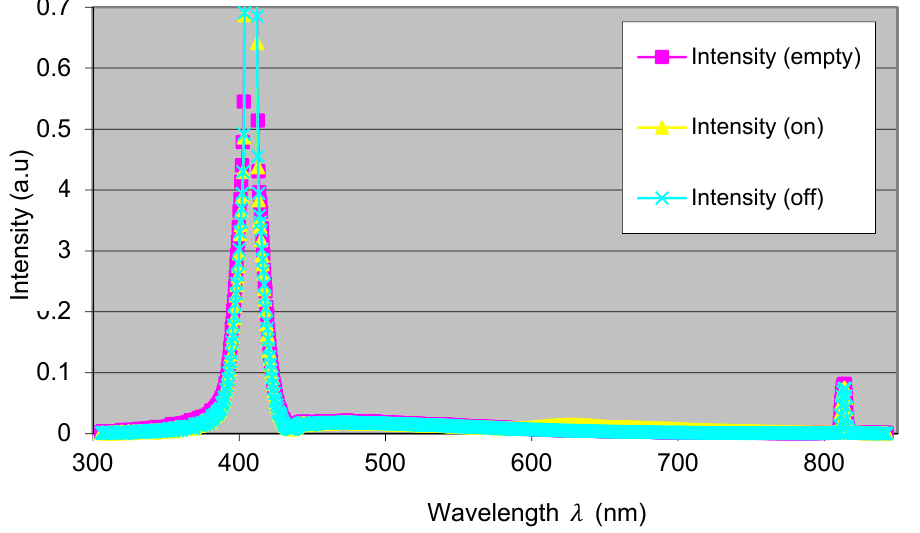
Figure 7. Photoluminescence quantum efficiency (PLQE) of curves of P5T single crystal.